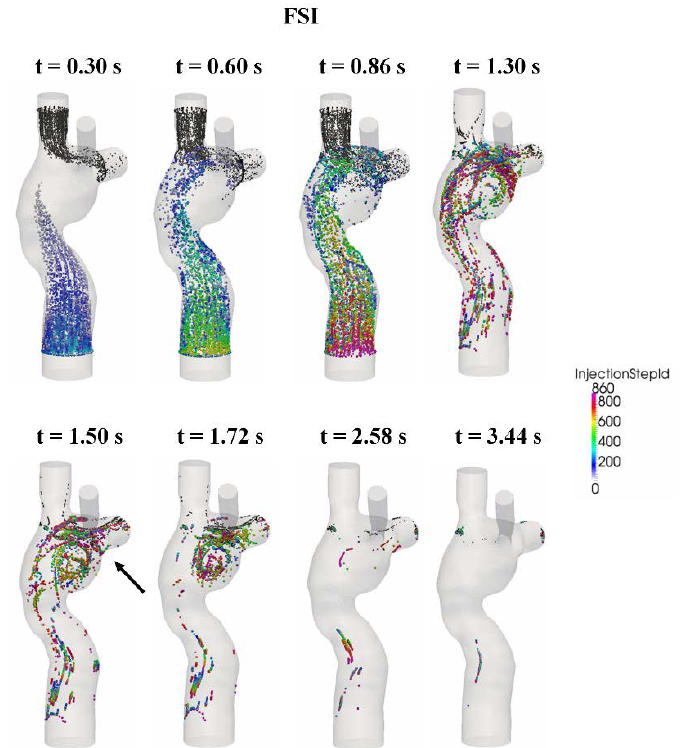
Figure 11. Progression of the particles seeded at the FP from the fluid-structure interaction (FSI) simulation. The FP particles are color coded by their seeding time step. SVC particles are colored black. FP: Fontan pathway, SVC: superior vena cava.